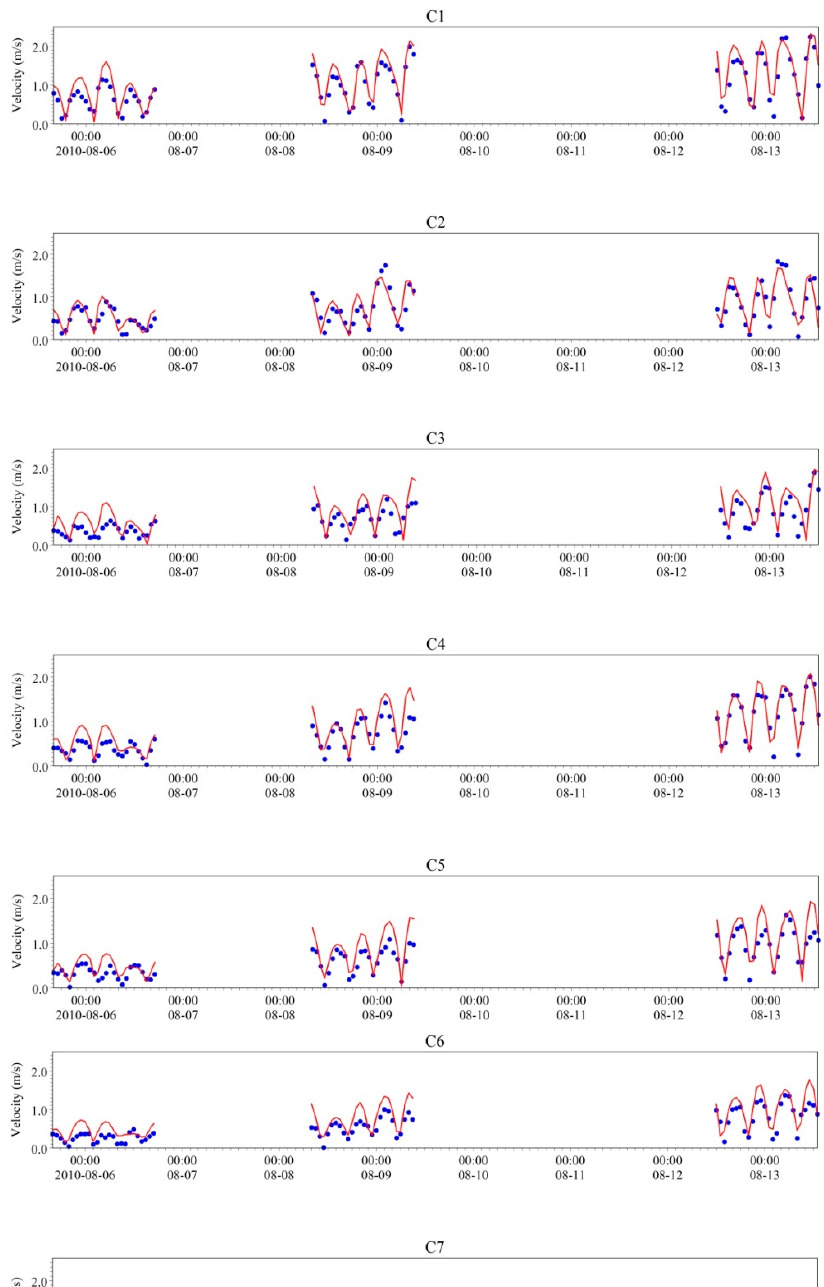
Figure 4. Tide level validation results ( signify the measured values; signify the simulated values).